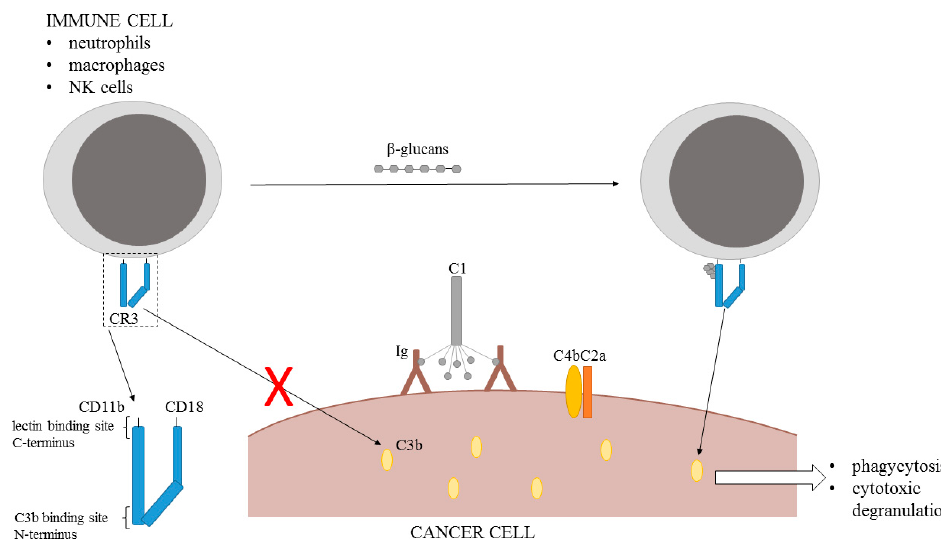
Figure 4. Mechanism of β -glucans action (CD—complement domain, CR—complement receptor, Ig—immunoglobulin).